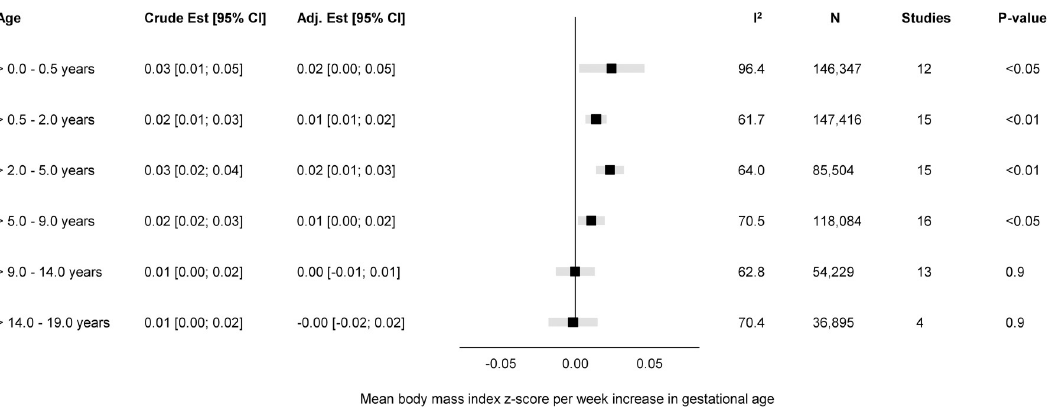
Fig 1. Forest plot of associations between GA (completed weeks) and BMI z-score. Overall unadjusted and adjusted estimates with 95% CIs from IPD meta-analyses of the study-specific linear regression models, where cohorts were assigned weights under the random-effects model. The dot in the forest plot represents the adjusted estimates, while the whiskers span the 95% CI, whereas I 2 - statistics (I 2 ), sample size (N), studies, and p -value (two-sided, < 0.05) relate to adjusted estimates. Estimates reflect a mean difference in BMI z-scores per week increase in gestational at birth in early infancy ( > 0–0.5 years), late infancy ( > 0.5–2.0 years), early childhood ( > 2–5 years), mid-childhood ( > 5–9 years), late childhood ( > 9–14 years), and adolescence ( > 14–19 years). Models are adjusted for sex of child, and the following maternal characteristics: age at child’s birth, education, height, prepregnancy BMI, smoking during pregnancy, parity, ethnic background, gestational diabetes and hypertension, and preeclampsia. Cohort-specific estimates were adjusted for the maximum available set of the confounding variables (see Table 1). BMI AU : AbbreviationlistshavebeencompiledforthoseusedinFigs 1 (cid:0) 4 attheendofeachfigurecaption : Pleaseverifythatallentriesarecorrect : , body mass index; CI, confidence interval; GA, gestational age; IPD, individual participant data.